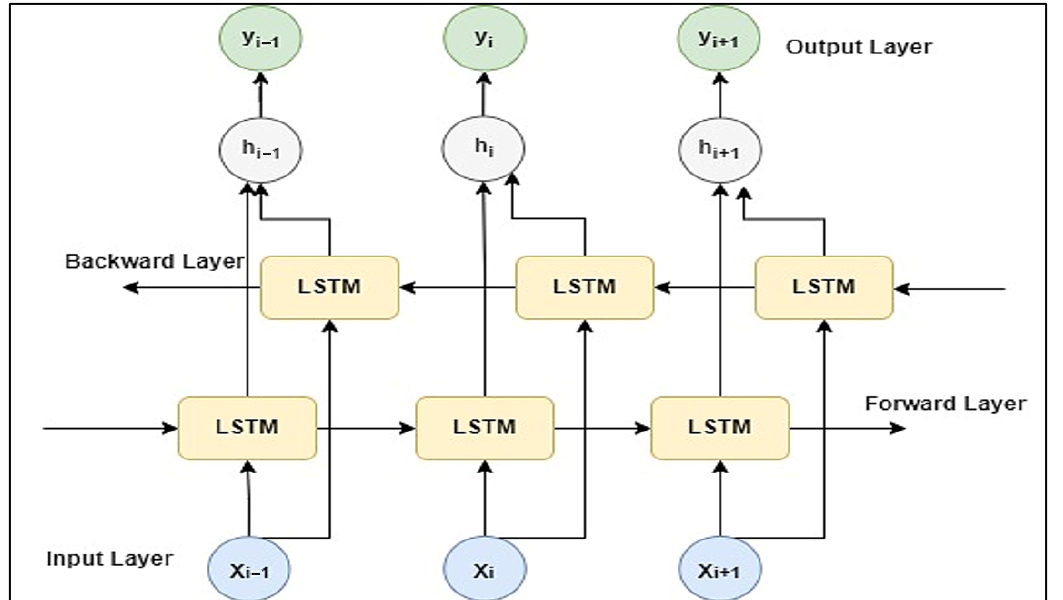
Figure 6 . The Bi-LSTM model architecture . Figure 6. The Bi-LSTM model